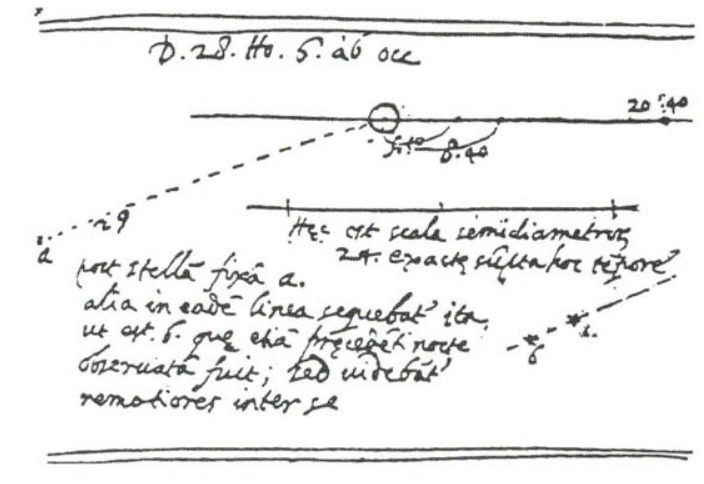
Fig. 2. Jupiter, three satellites, SAO star #119234 ("a") and Neptune ("b") were drawn by Galileo on this diagram of January 28, 1613. Galileo thought that Neptune was just a "fixed star", but he did notice that the stars seemed to have moved since the preceding